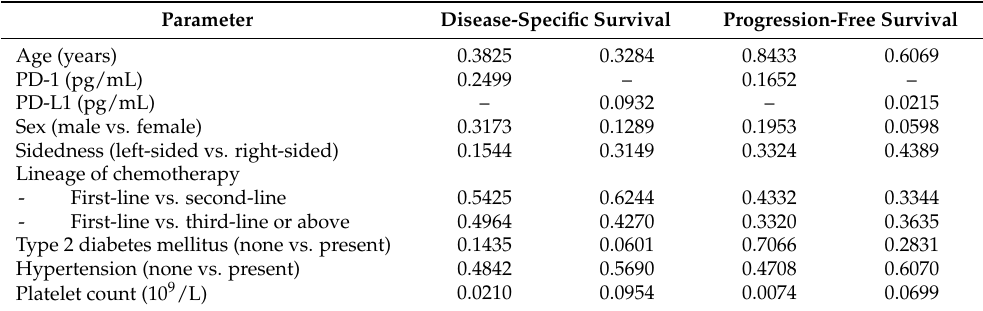
Table 2. The p -values obtained for survival models investigating the multivariate effect of PD-1 and